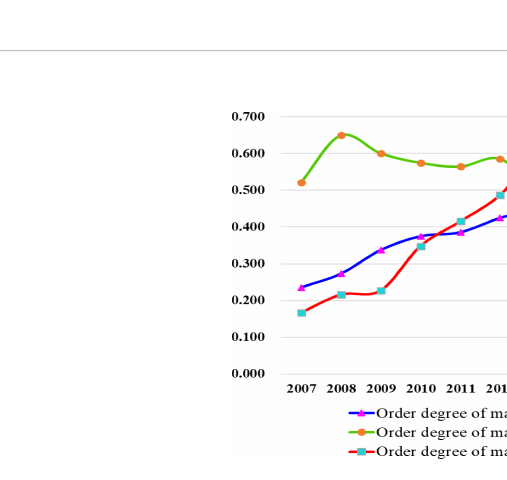
FIGURE 3 Order degree of subsystems of marine composite system in Shandong Province from 2007 to 2019.